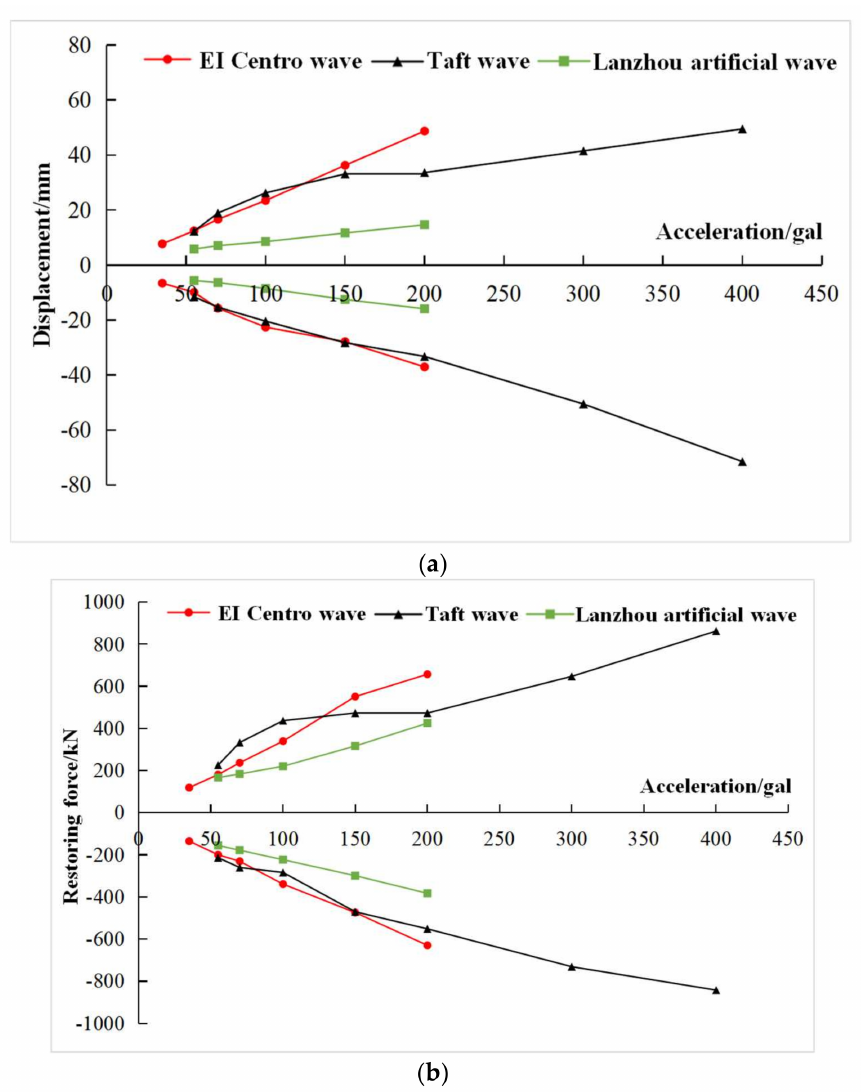
Figure 11. Peak acceleration-displacement curve and peak acceleration-restoring force curve.; ( a ) Peak acceleration-displacement curve; ( b ) Peak acceleration-restoring force